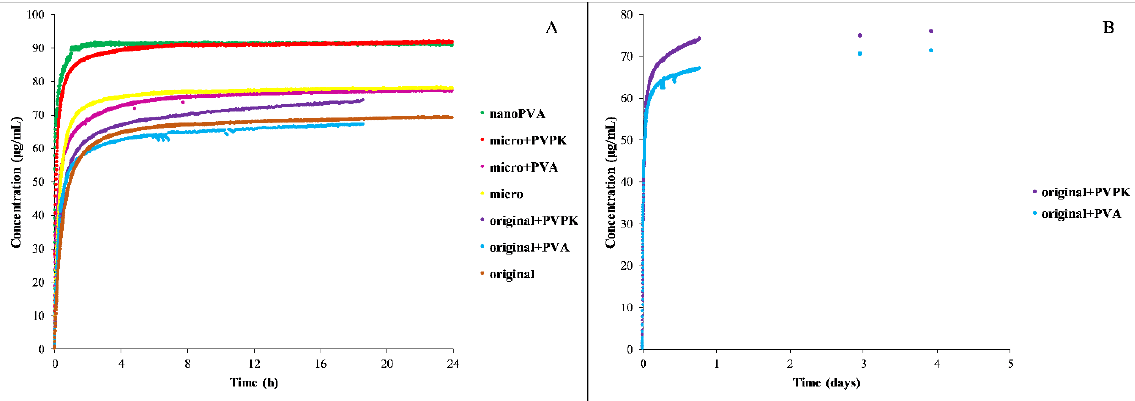
Figure 8. Dissolution profile of all niflumic acid samples ( A ) and the physical mixtures of the original compound with excipients ( B ) in FeSSIF blank buffers .